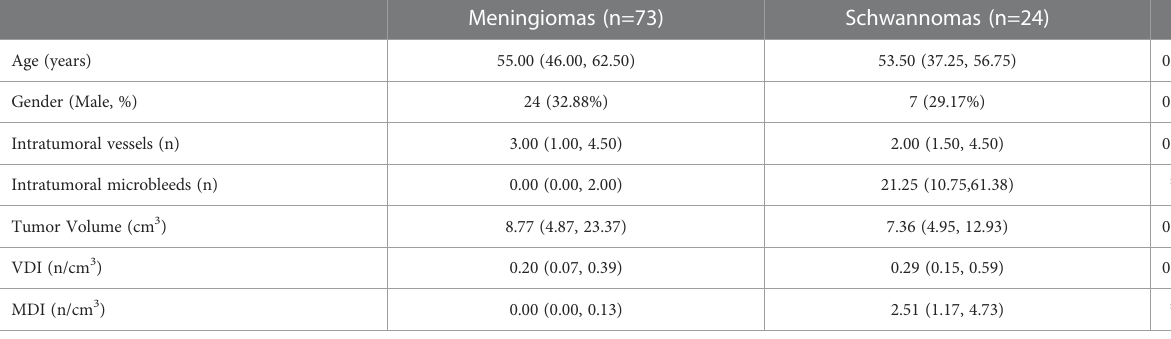
TABLE 2 Comparison of CE-T 1 WI FSBB features between meningiomas and